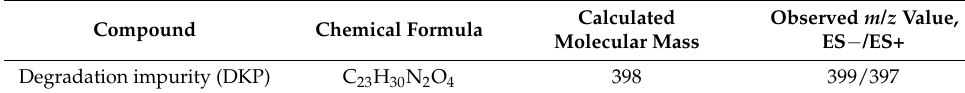
Table 2. The m/z values of [M − H] − [M + H] + for DKP and RAM.